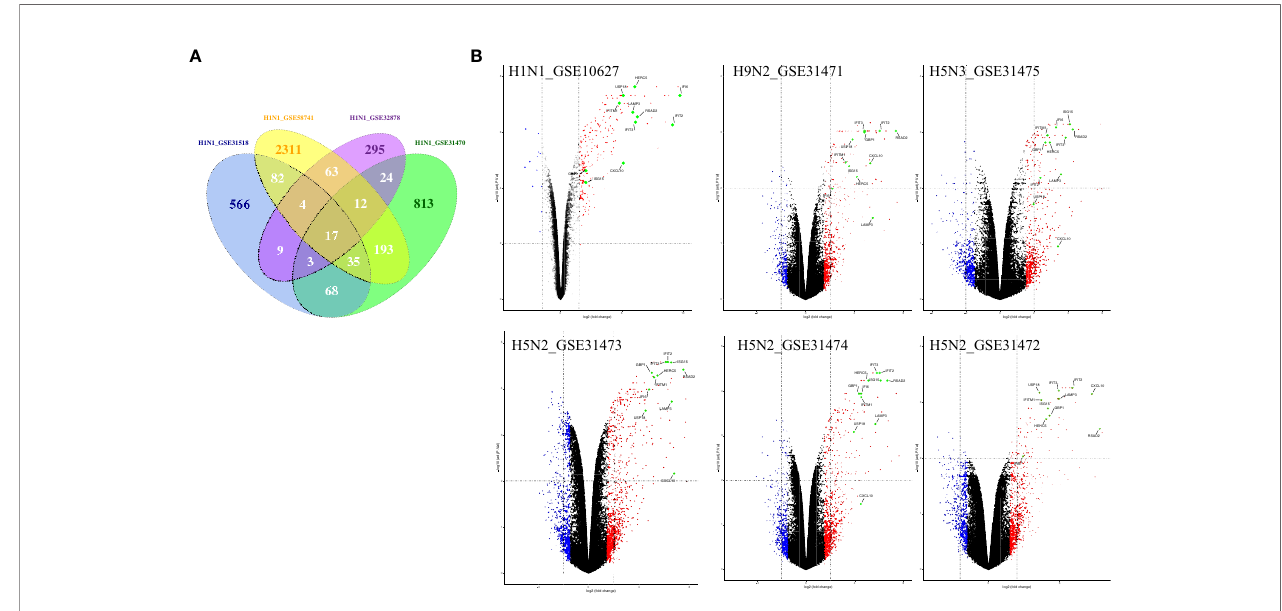
FIGURE 1 | The common gene expression in A549 cells infected with IAV. (A) The Venn diagram shows the overlapping genes in 4 H1N1-infected datasets, 17 genes were common to the 4 H1N1-infected groups; (B) Volcano plots showing differentially expressed genes for H1N1, H9N2, H5N3, and H5N2-infected A549 cells. The vertical dashed lines correspond to 1.5-fold up and down expression, and the horizontal dashed line represents a p- value of 0.01. Blue and red dots indicate signi fi cantly downregulated and upregulated genes, respectively. Genes that were not classi fi ed as differentially expressed are plotted in black. The 11 overlapped genes identi fi ed in different IAV subtype infection are exhibited in the Volcano plots.